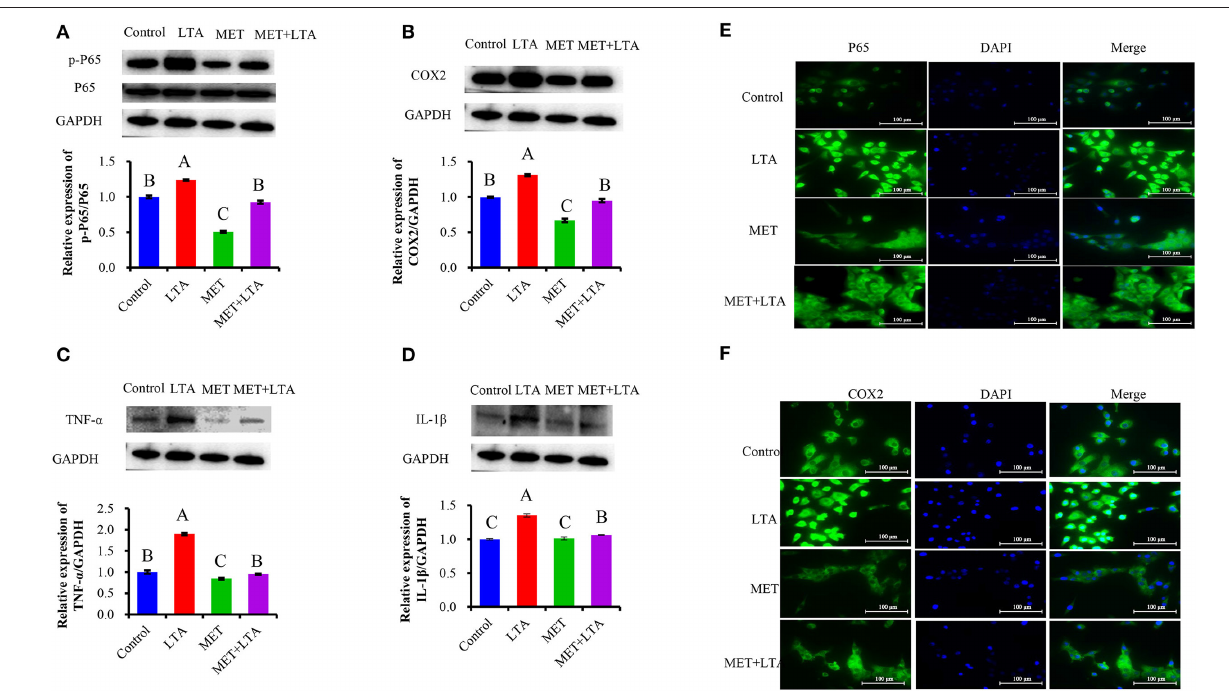
Frontiers in Veterinary Science |